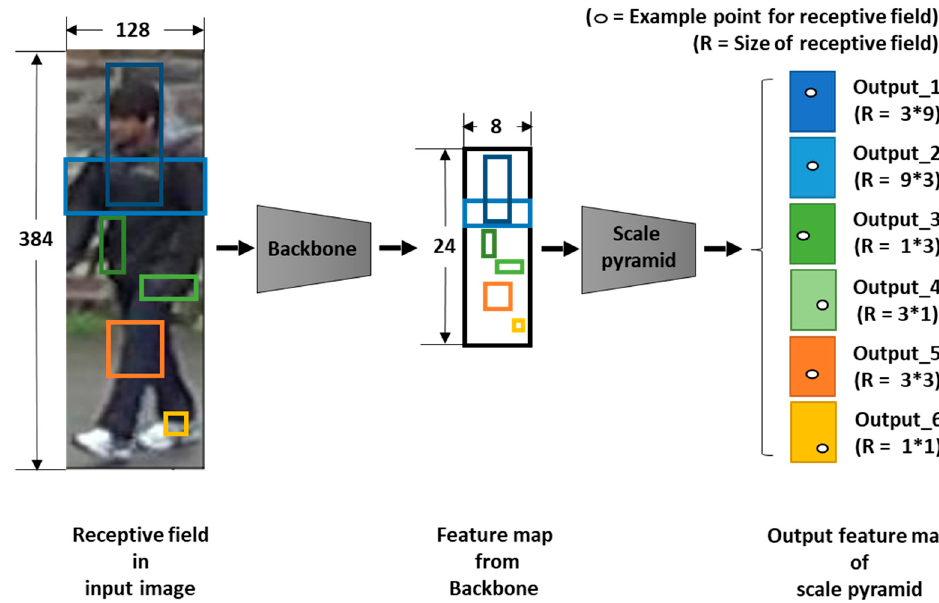
Figure 4. Receptive field example of scale pyramid on input image and feature map.